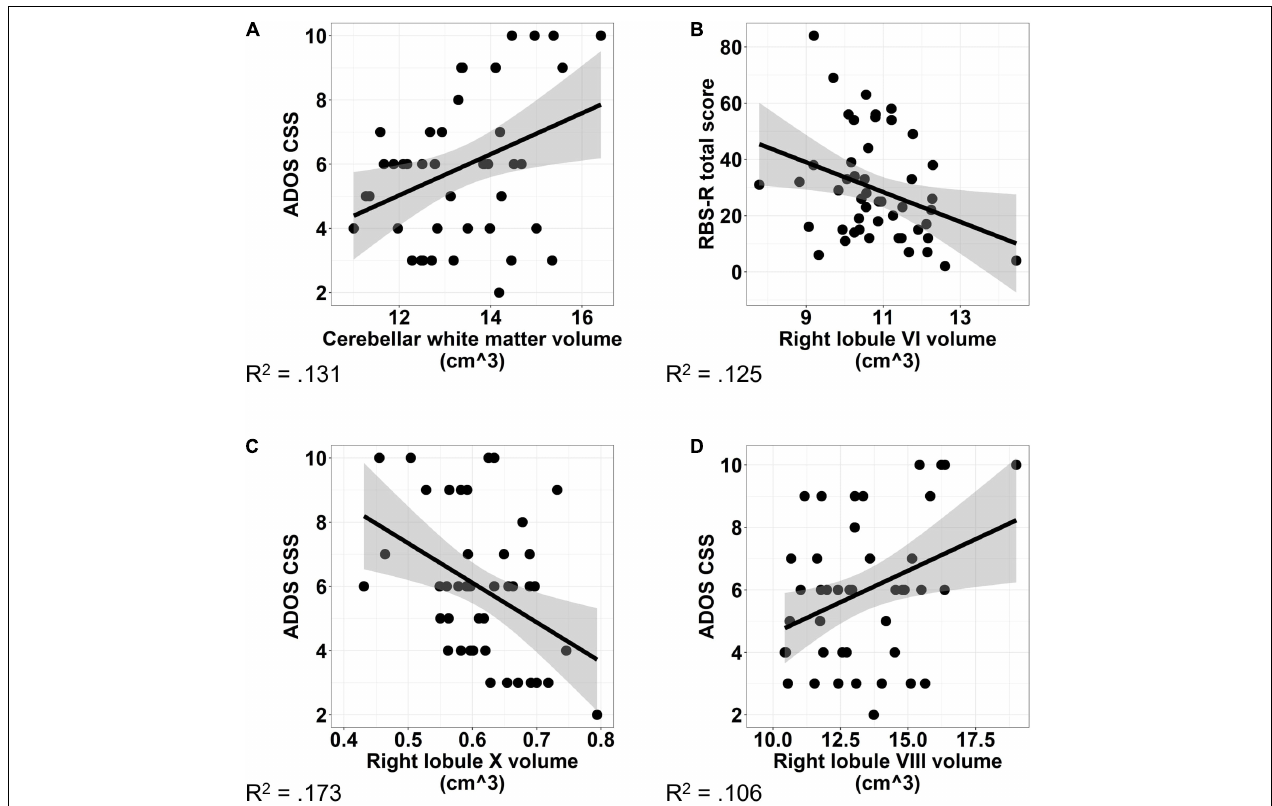
FIGURE 6 | Associations between cerebellar volume and ASD symptom severity. Increased volume of cerebellar white matter (A) and right lobule VIII (B) were associated with increased ASD symptom severity as measured using the ADOS-2 Calibrated Severity Score. Increased volume of right lobule X (C) was associated with reduced ASD symptom severity. Increased volume of right lobule VI (D) was associated with reduced severity of RRBs as measured using the Repetitive Behaviors Scale—Revised. The shaded region reflects the 95% confidence interval of a linear fit. R 2 values reflect the proportion of variance in clinical symptoms accounted for by the cerebellar volume in a one-term model. ADOS CSS, Autism Diagnostic Observation Schedule Calibrated Severity Score; RBS-R, Repetitive Behaviors